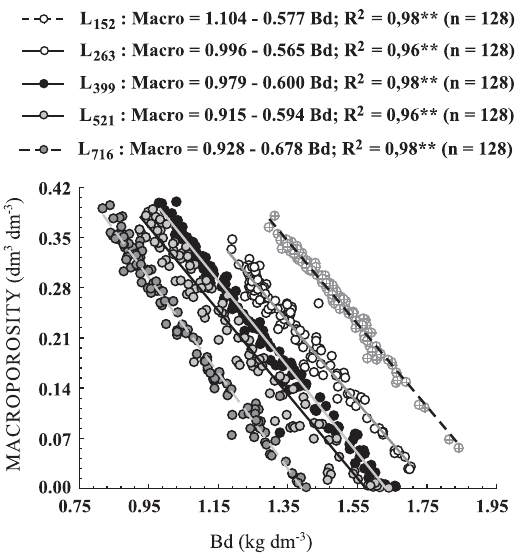
GO.Figure 3. Macroporosity based on the increase of bulk density (Bd) in Latosols (L) in the county of Rio Verde, GO. Subscripts in the abbreviation of Latosols indicate clay contents (g kg -1